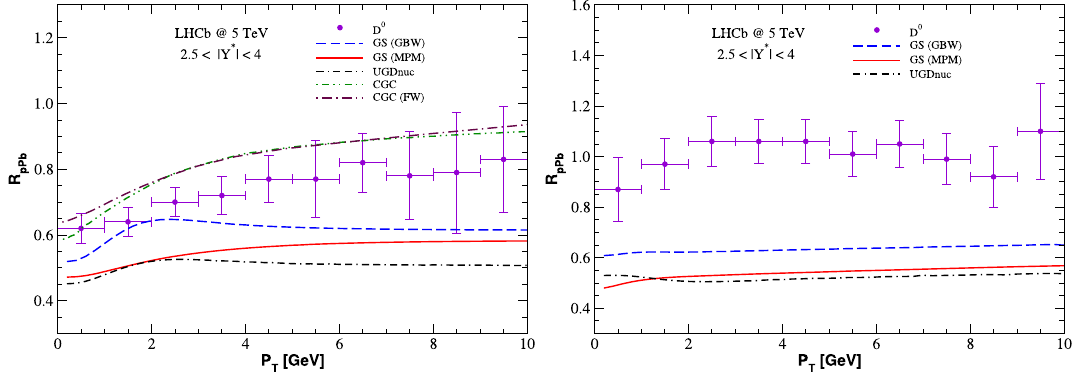
Fig. 7 The nuclear modification factor for D 0 meson production in √ pPb collisions at s = 5 TeV in the forward (left panel) and backward data (right panel) considering the common rapidity range, 2 . 5 < | Y ∗ | < 4. In particular, the predictions given by the GS (GBW) ,